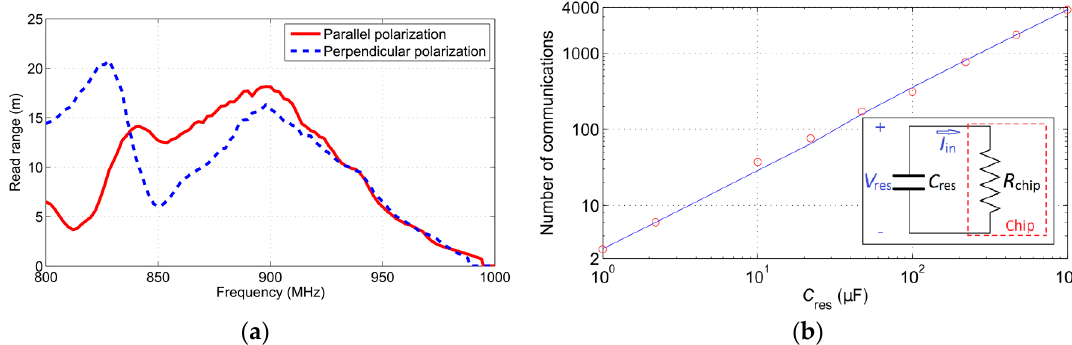
Figure 4. Performance of the RFID communication module: ( a ) Maximum read range of the RFID tag powered by a 3.3 V battery; ( b ) Number of communications of the RFID module that can be supported by capacitors with different